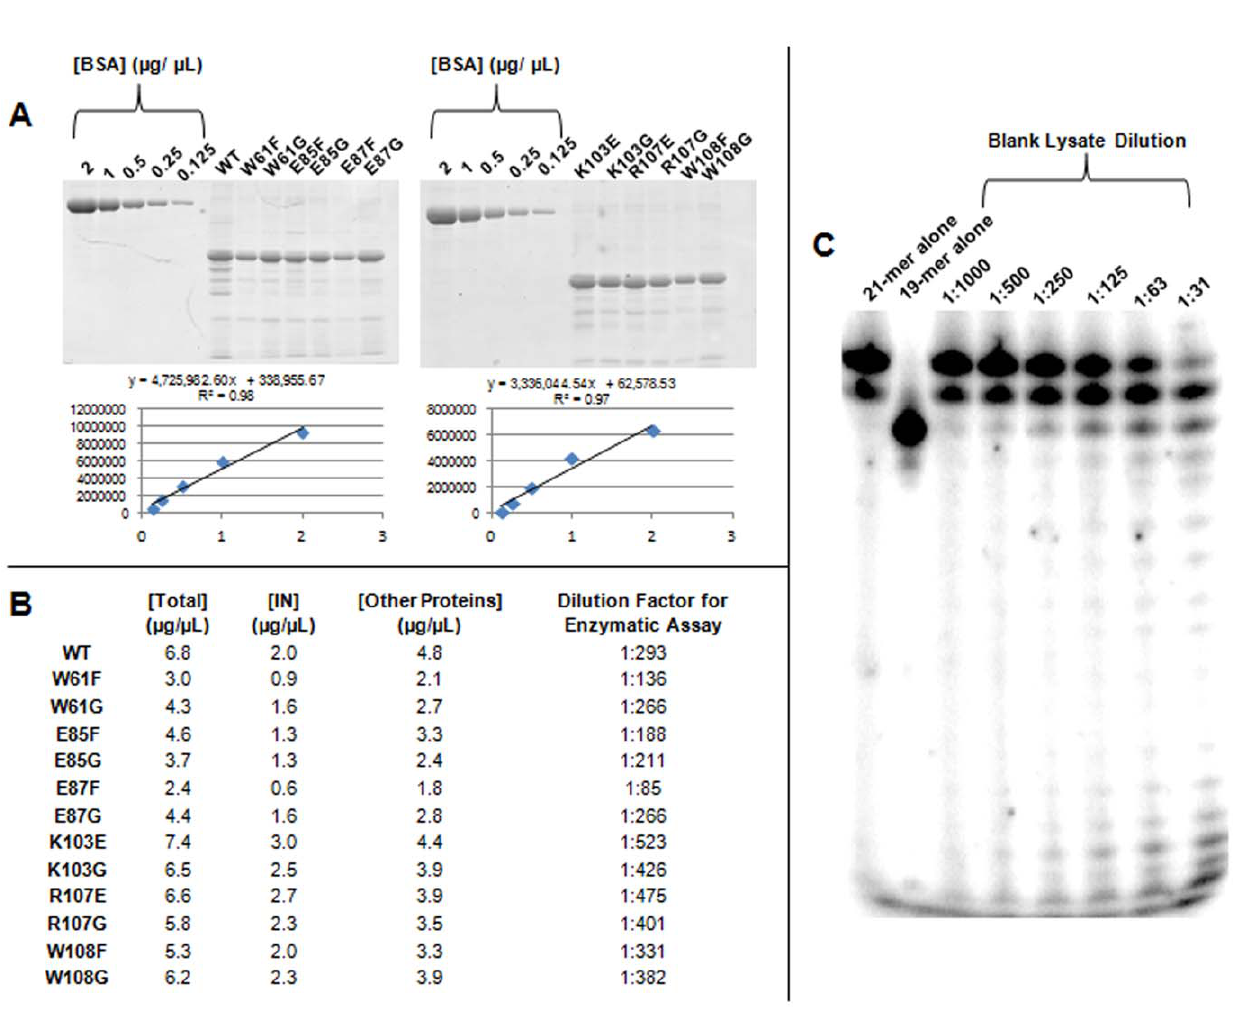
Figure 2. Cellular proteins in E.coli lysate confer a negligible level of non-specific DNA cutting. A) PAGE demonstrating the purity of each IN lysate preparation. Protein concentration standard curves were calculated from densitometric analysis of BSA titrations spanning five concentrations, from 0.125 m g/ m L –2.0 m g/ m L. Band intensity of IN within each total lysate was then quantified, and concentration of total IN was calculated using BSA standard curve line equation. B) Chart outlining total lysate concentration, IN concentration within lysate, and dilution factor necessary for 300 nM final IN concentration within enzymatic assay. Dilution factors necessary for each IN preparation ranged from 1:85 (E87F) to 1:475 (R107E). C) Effect of E. coli BL21(DE3)pLysS lysate on nonspecific nucleolytic degradation of radiolabeled 21-mer DNA. Radiolabeled 21-mer